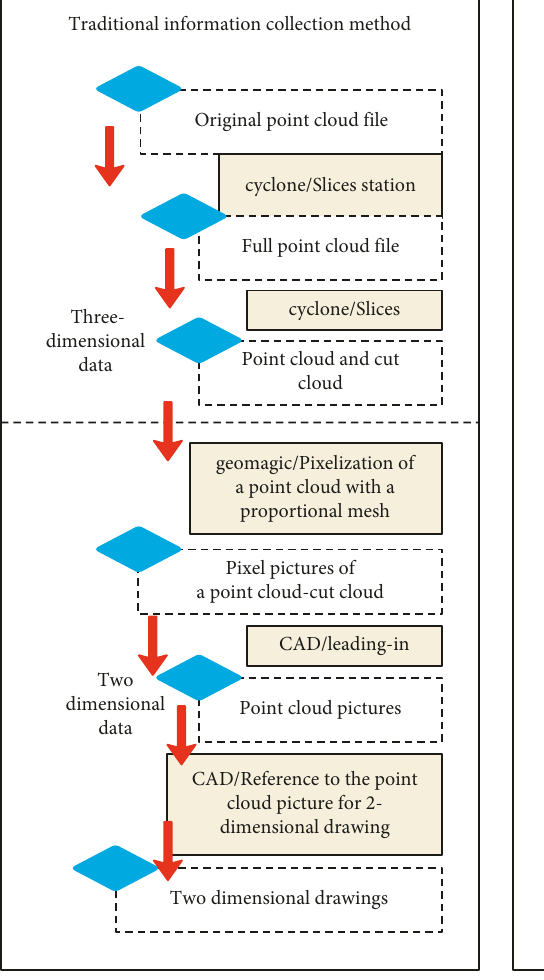
Figure 8: The process of the traditional way and the BIM way of working. Table 1: Evaluation of building structure construction.